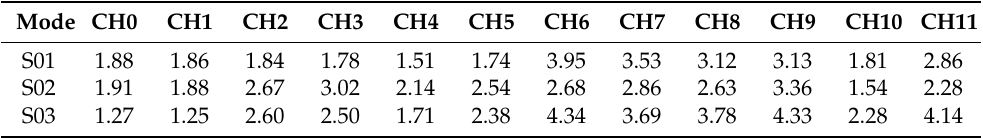
Table 3. Pressure fluctuation peaks in time domain under different operating conditions.